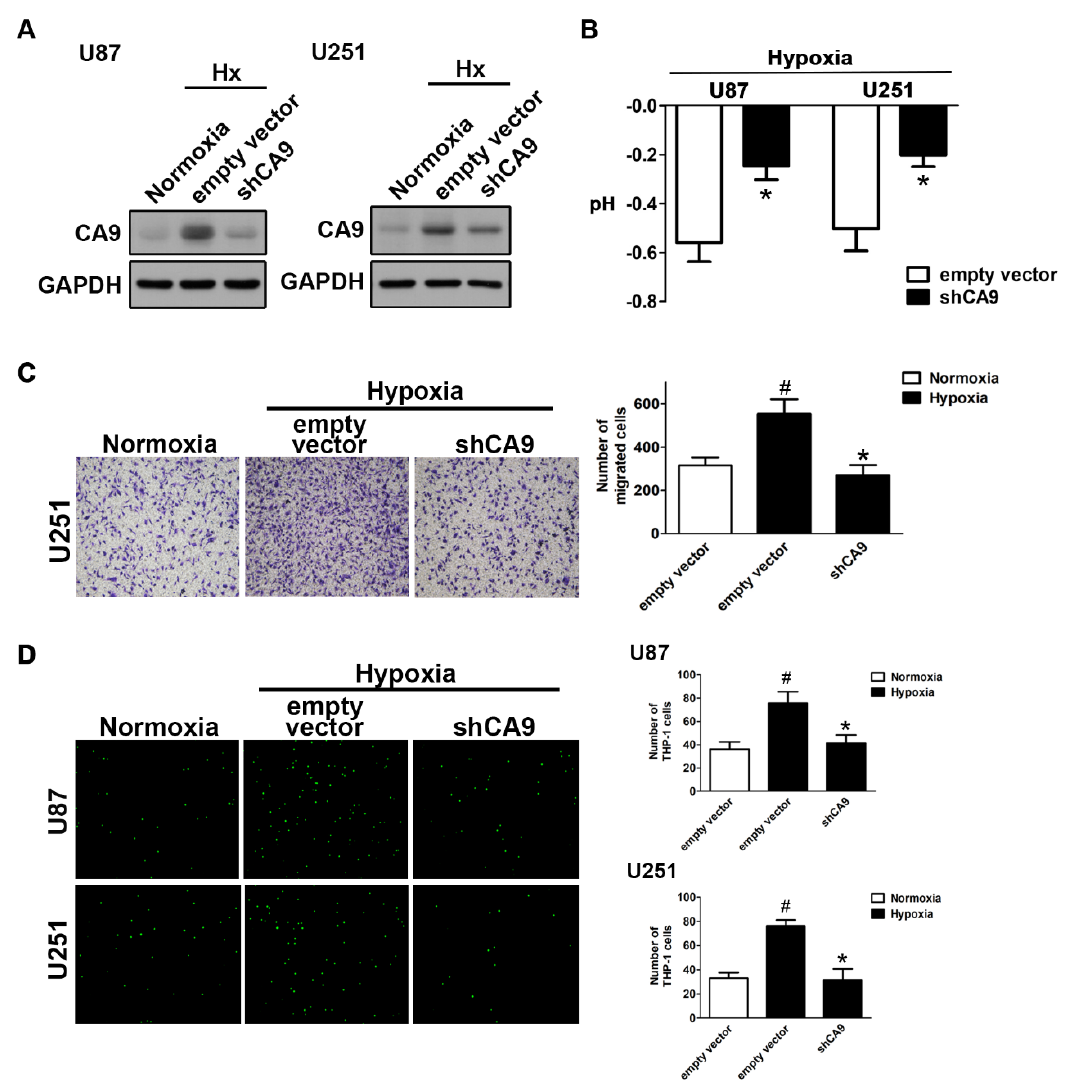
Figure 3. The knockdown of CAIX reduces hypoxia-induced GBM motility and monocyte adhesion to GBM. ( A ) U87 and U251 cells were transfected with empty vector or wild-type CAIX for 24 h and exposed to hypoxic conditions (1% O 2 ) for 24 h. CAIX expressions were determined by Western blot using whole cell lysates. The pH values of the culture media are shown in ( B ). In vitro migration activities were measured after 24 h with a transwell assay and then visualized using a digital camera ( C , left panel). The quantification of GBM migration abilities is shown in the right panel. BCECF-AM- labeled-THP-1 was added to GBM cells for 30 min, and, subsequently, the adherence of THP-1 was